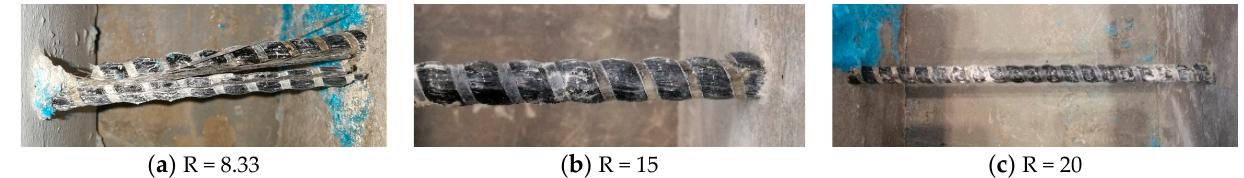
Figure 7. Failure modes of connectors with installation angle of 90°.